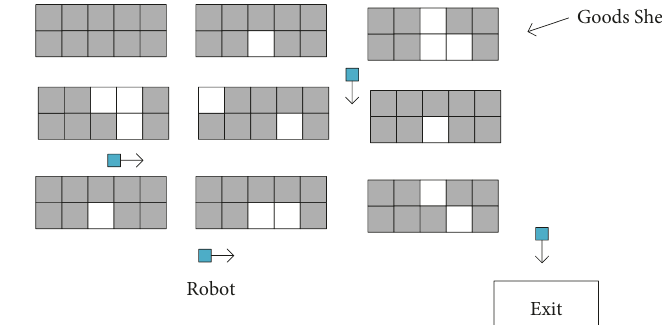
Figure 1: Floor plan of intelligent warehouse.